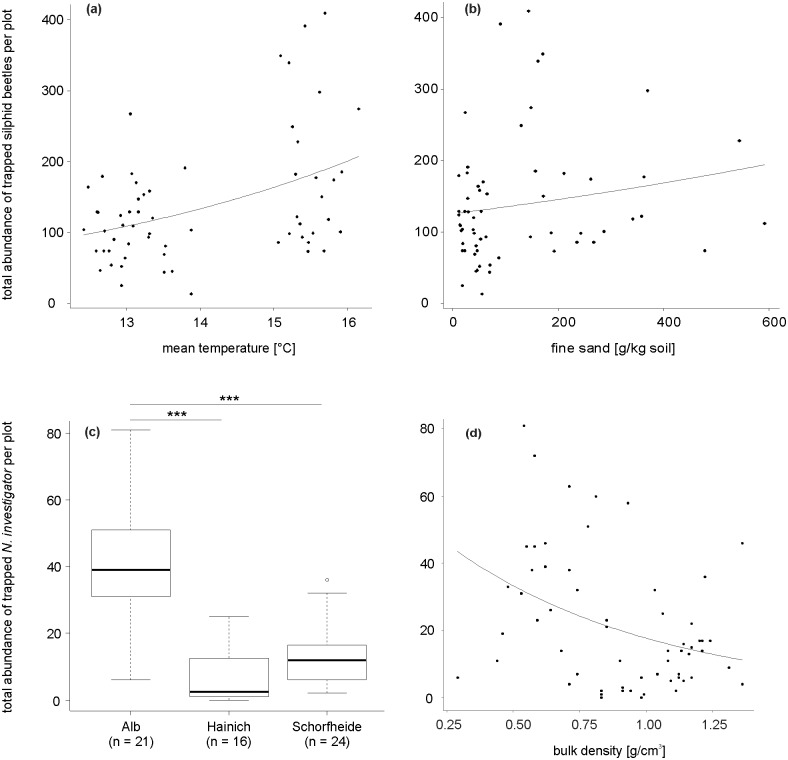
Effects of environmental characteristics on overall silphid beetle and N. investigator abundance.Relationship between total abundance of trapped silphid beetles per plot and a mean ambient temperature and b fine sand content. Relationship between total abundance of trapped N. investigator per plot and c region and d bulk density. a & b: observed values (circles) and predicted values (connected by a line) for the negative binomial-GLMM model (deviance = 10.39, P = 0.006), c: box plot showing the median, the 75% percentile, the 25% percentile, the highest non-extreme value, the smallest non-extreme value, and the extreme values inside a category (negative-binomial GLMM model comparison, deviance = 49.19, P < 0.001; Tukey tests, ***P < 0.001), d: observed values (circles) and predicted values (connected by a line) for the negative-binomial GLMM model (deviance = 56.44, P < 0.001).